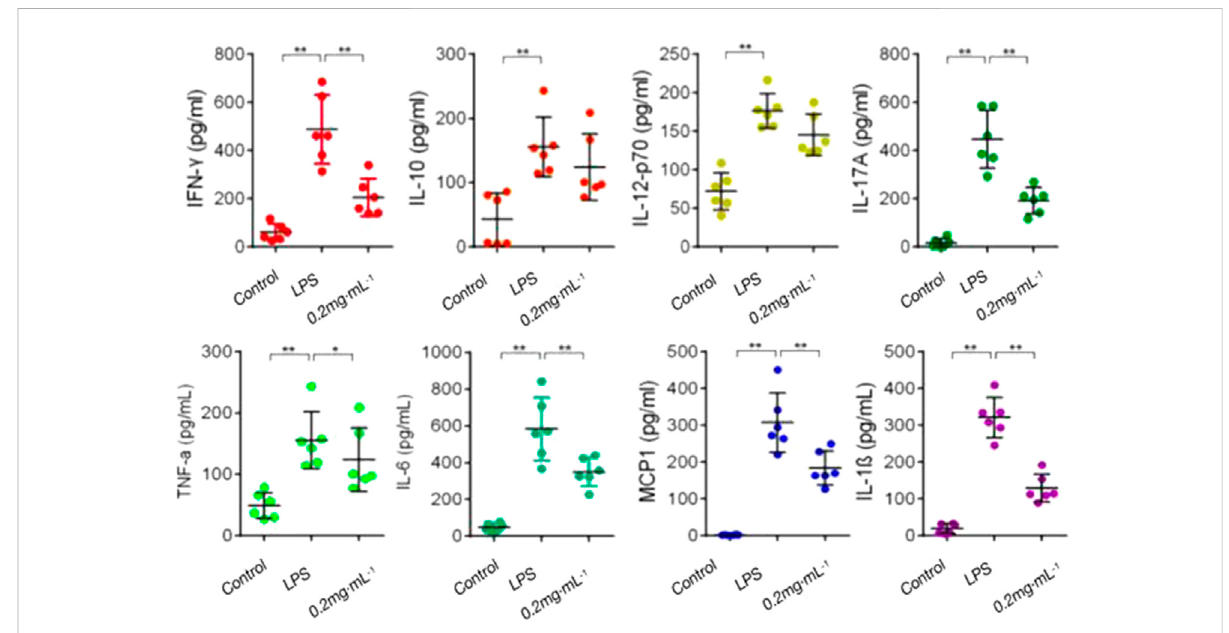
FIGURE 5 Effect of DF on Th cytokines. **, p < 0.01, compared with model group.